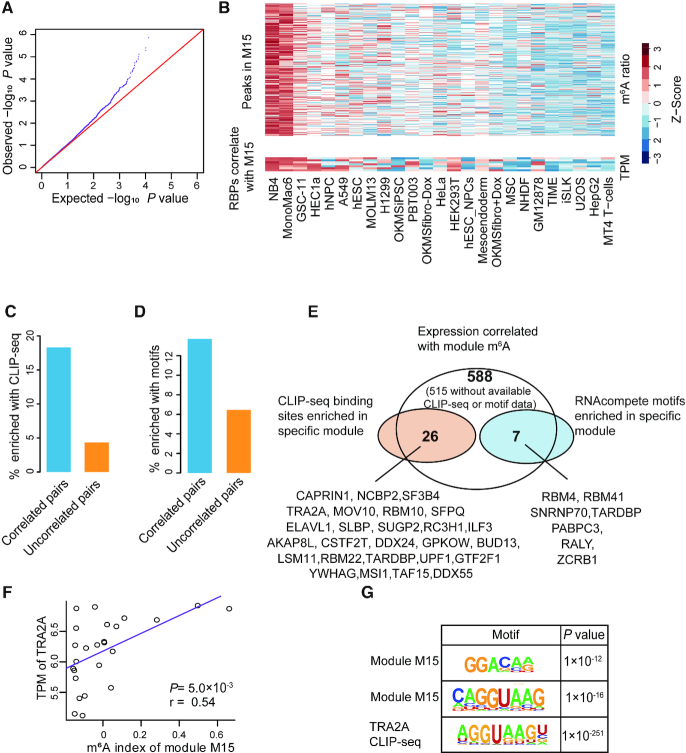
Systematic identification of m6A regulators. (A) Q-Q plot comparing the distributions of expected P-values and observed P-values of the correlations between the gene expressions of RBPs and m6A indexes of the co-methylation modules. (B) Heatmaps representing the m6A ratios of the m6A peaks within the module M15 (upper panel) and the gene expressions of the RBPs that significantly correlated with the m6A indexes of M15 (lower panel). The cell lines are sorted according to the m6A indexes of M15. (C andD) Barplot representing the percentages of the pairs of RBPs and modules that enriched for CLIP-seq binding sites (C) or motifs (D) of the RBPs out of the pairs that showing significant and non-significant (top 1000 least significant) correlations between gene expressions of the RBPs and the m6A indexes of the modules. (E) Venn diagram demonstrating the identification of 32 high-confidence m6A regulators. (F) Scatter plot showing the correlation between TRA2A gene expression and m6A indexes of module M15 across all cell lines. (G) Representative motifs enriched in module M15 and TRA2A CLIP-seq targets.